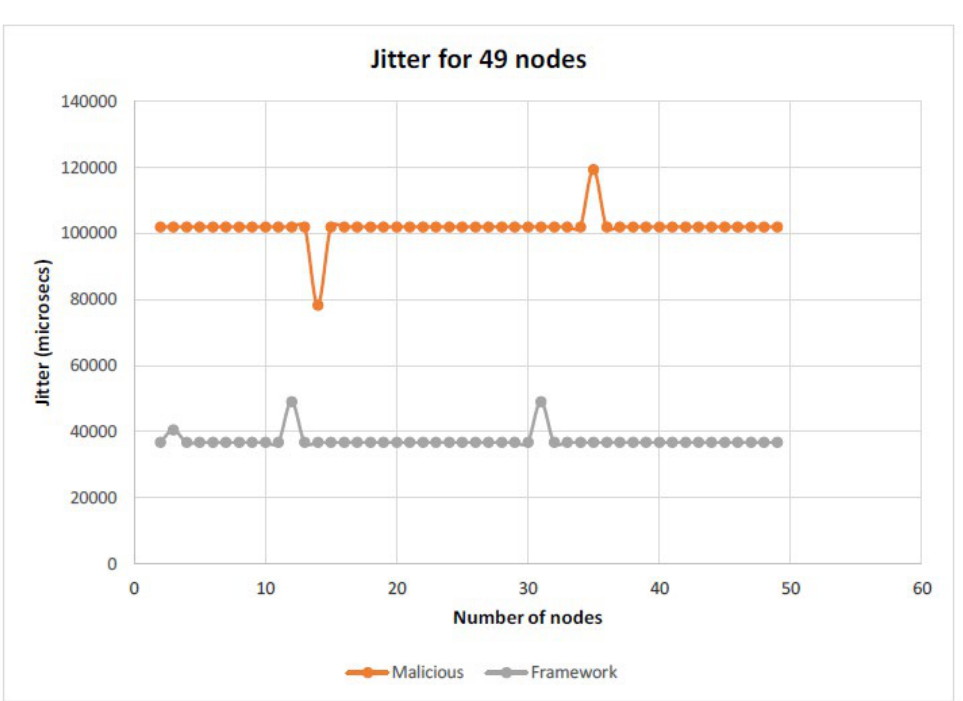
Figure 15. Delay for 49 nodes.